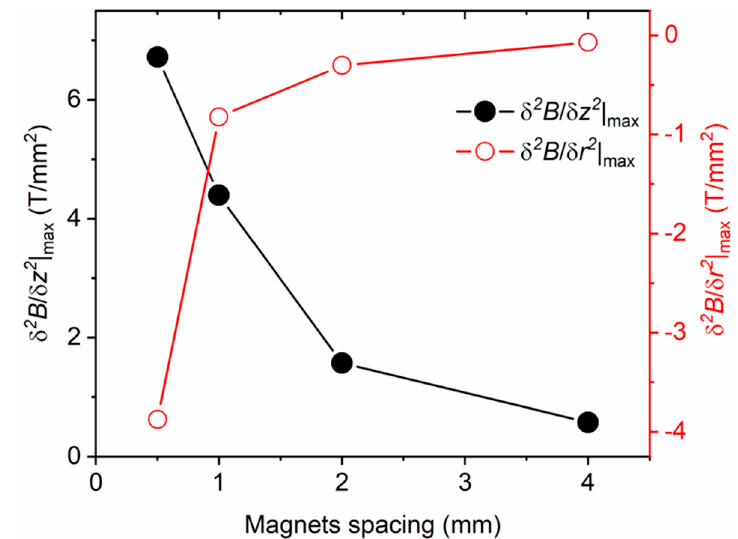
Figure 5. A plot of maximum second derivative magnetic induction field obtained from FEMM simulation with respect to magnet poles spacing ( d 12 ). Here, two identical disk NdFeB magnets were repulsively arranged face-to-face (2 mm apart) and the δ 2 Β/ δ z 2 | max and δ 2 Β/ δ r 2 | max were determined along symmetric ( z ) and the radial ( r ) axes, respectively.